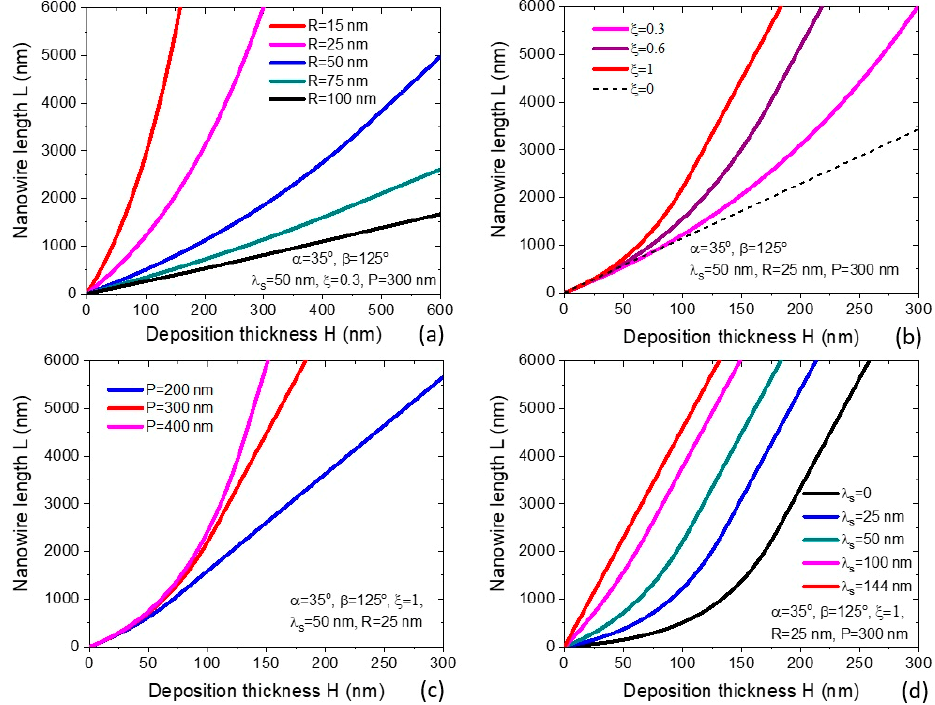
Figure 2. NW length versus deposition thickness obtained from Equations (16)–(18) for VLS NWs with α = 35 ◦ , β = 125 ◦ , c = 1, and ϕ = 1 at ( a ) a fixed ξ of 0.3, λ s = 50 nm, and P = 300 nm for different NW radii shown in the caption; ( b ) a fixed λ s of 50 nm, P = 300 nm, and R = 25 nm for different coefficients ξ shown in the legend (the dashed straight line corresponds to the limiting case of ξ → 0); ( c ) a fixed ξ of 1, λ s = 50 nm, and R = 25 nm for different pitches shown in the legend; and ( d ) a fixed ξ of 1, R = 25 nm, and P = 300 nm for different widths of the collection ring λ s shown in the legend.